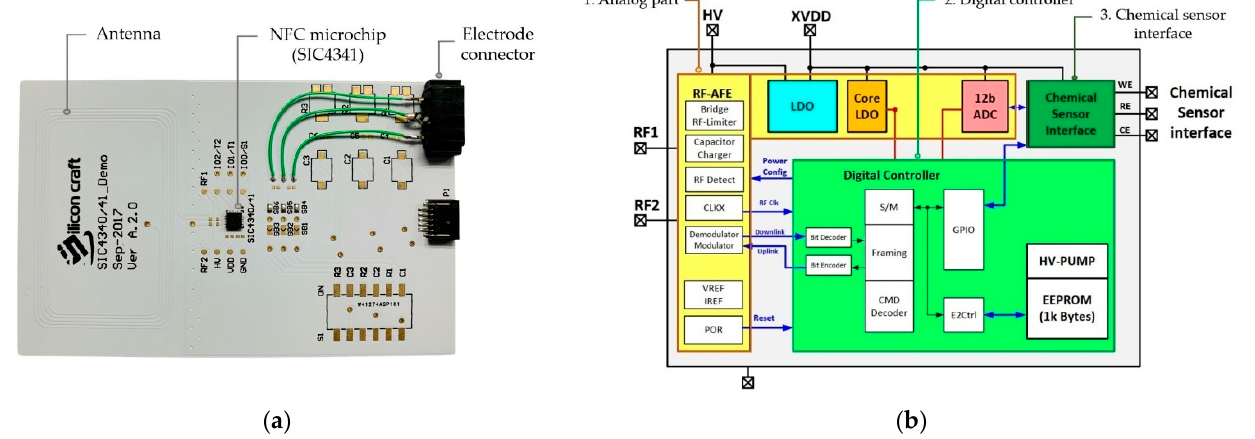
Figure 2. ( a ) Hardware components consisting of a planar antenna, near-field communication (NFC) microchip (SIC4341) and connector for electrode interface. ( b ) The integrated circuit of the NFC potentiostat, which includes (1) an analog part, (2) digital controller and memory unit and (3) the chemical sensor processing.